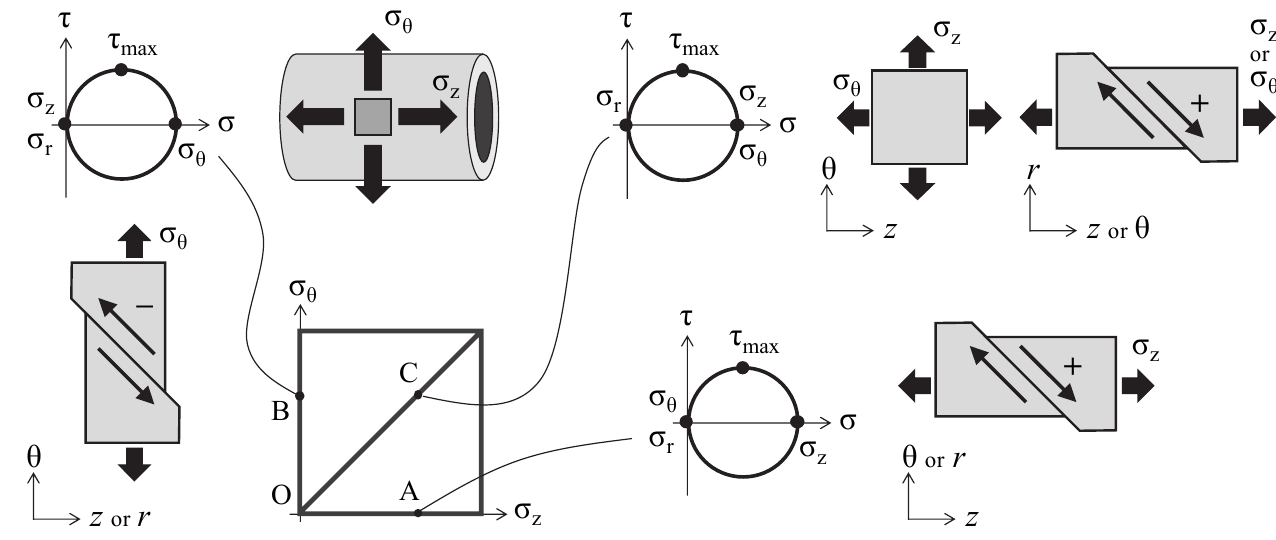
Figure 7: Maximum principal shear stress planes at each loading